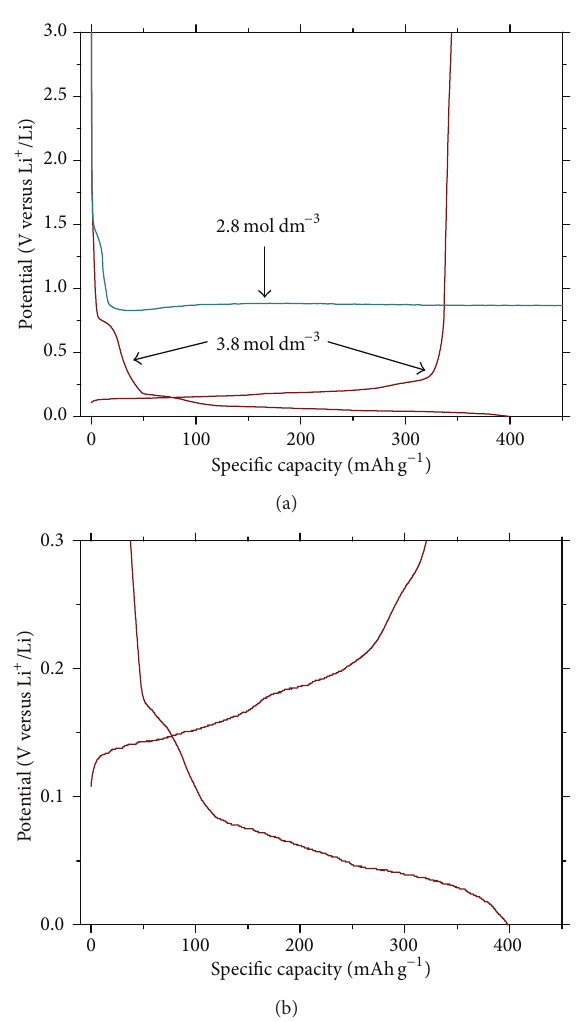
Figure 1: (a) Charge and discharge curves in the first cycle of natural graphite powder (NG-7) in 2.8 and 3.8 moldm −3 LiClO 4 dissolved in PC. (b) Magnified view of panel